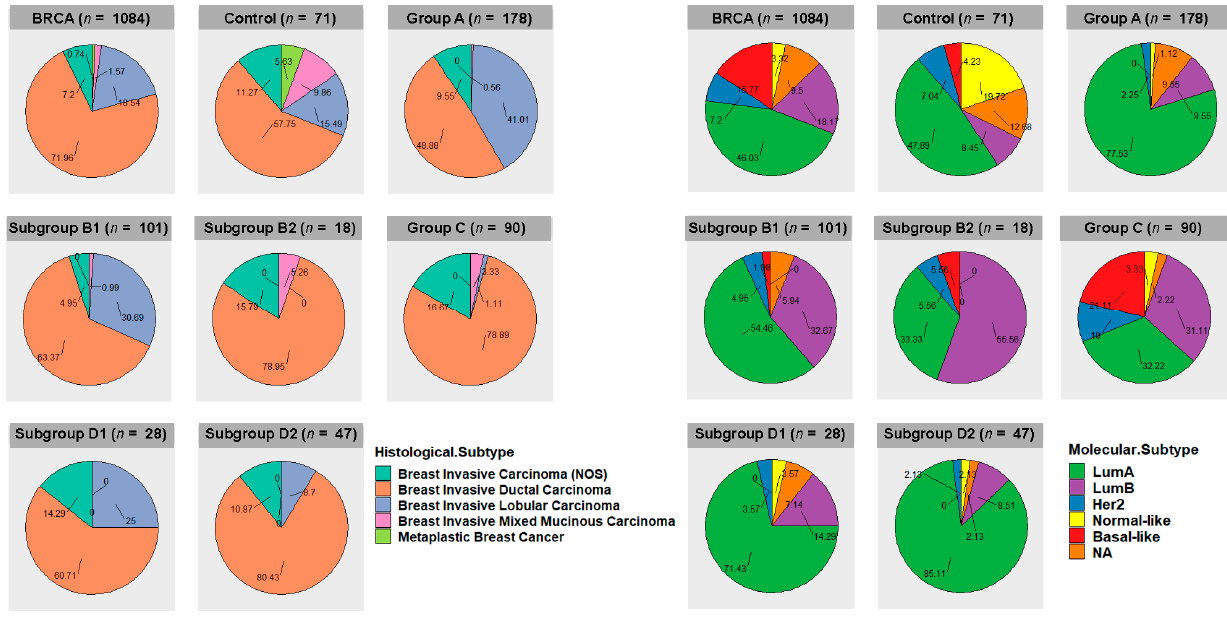
Figure 10. Frequencies of histological subtypes (left panels) and molecular subtypes (right panels) in the different 1,16-chromogroups.